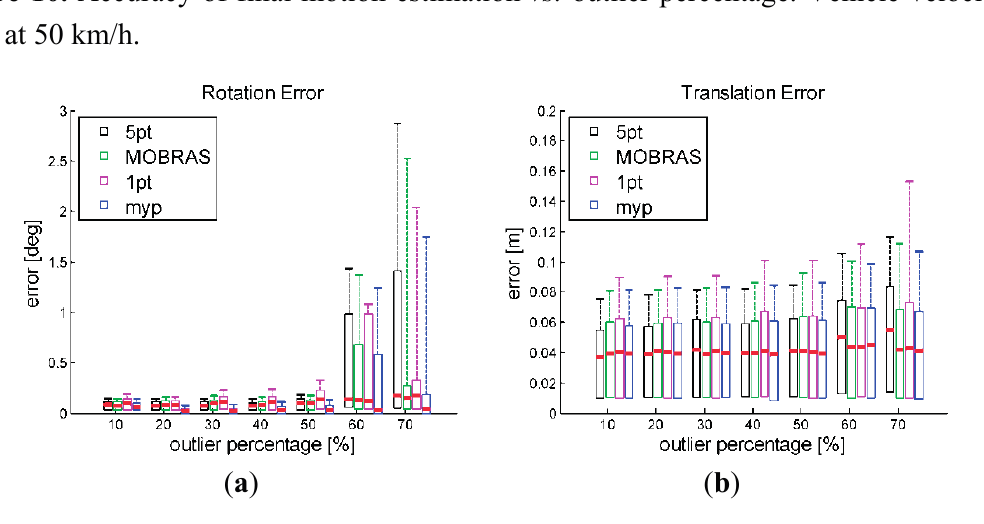
Figure 11. Accuracy of final motion estimation vehicle velocity level. Outlier percentage is set to